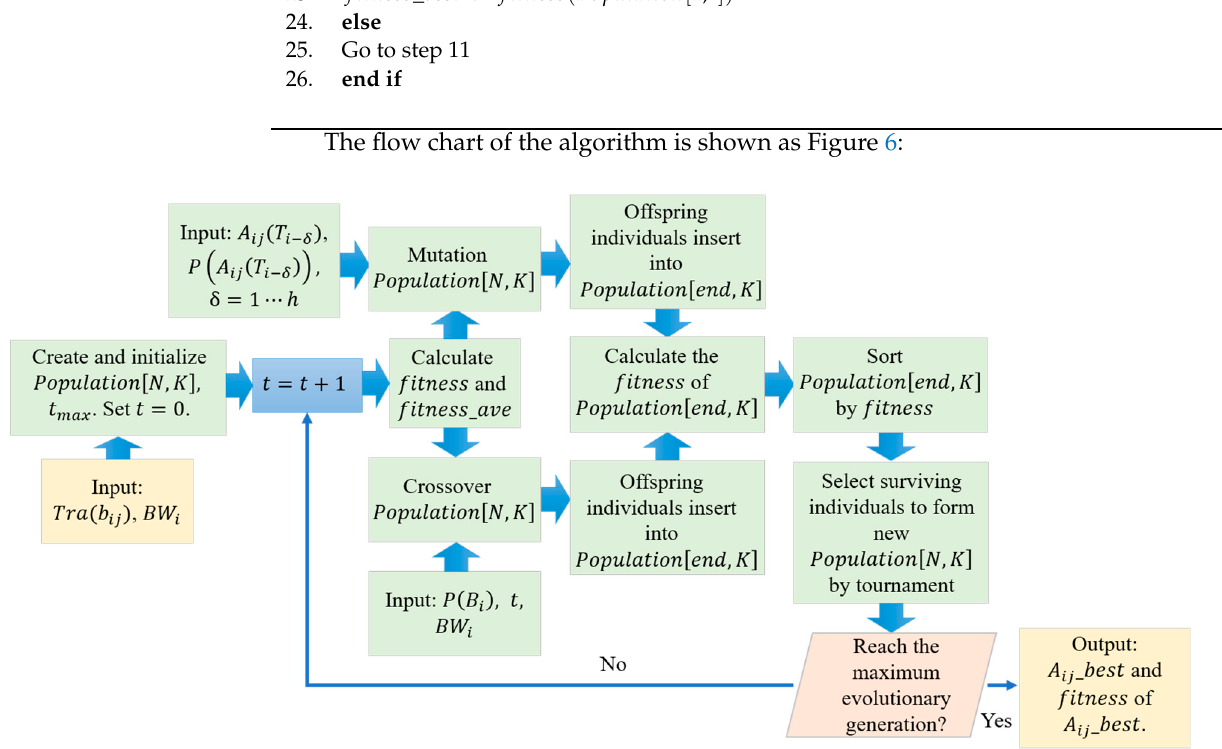
Figure 6. Flow Chart of load balancing method for satellite IoT beam.